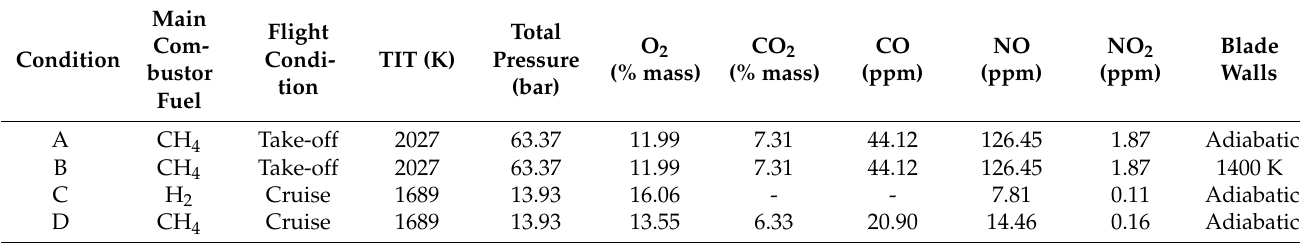
Table 2. Operating conditions investigated and their resulting turbine inlet conditions used as boundary